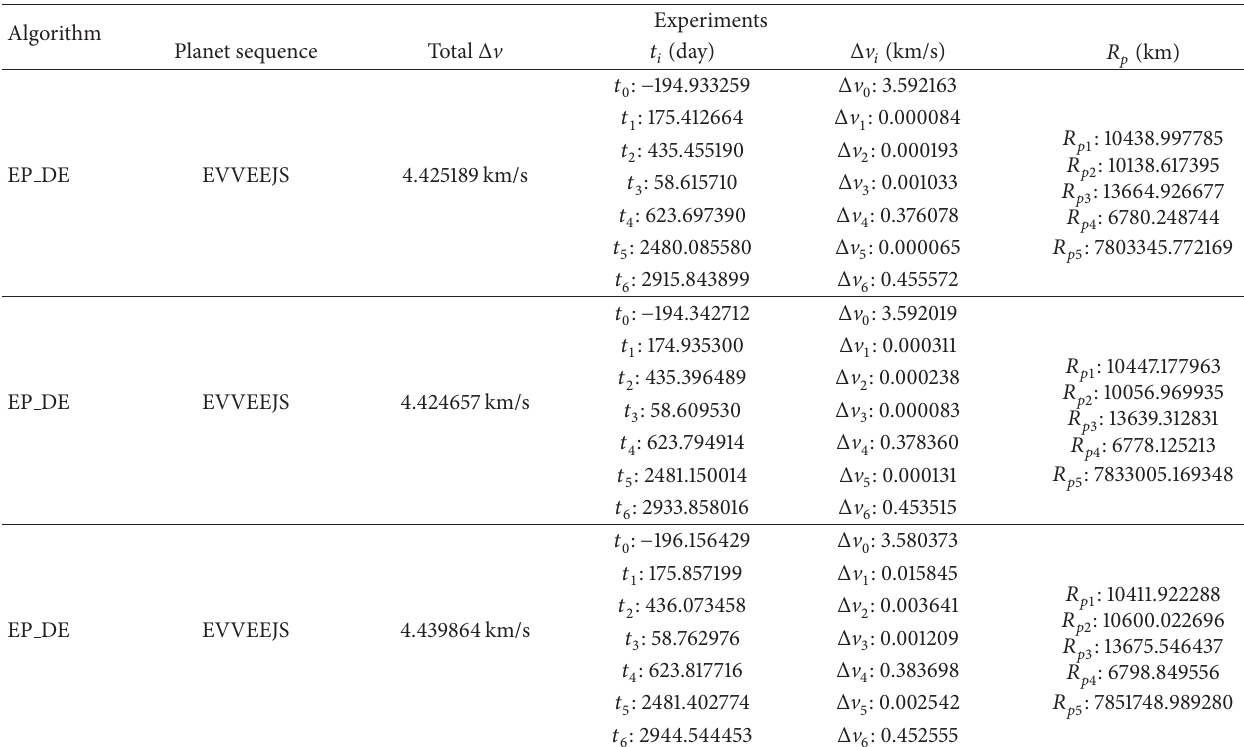
Table 17: Different results of Cassini for